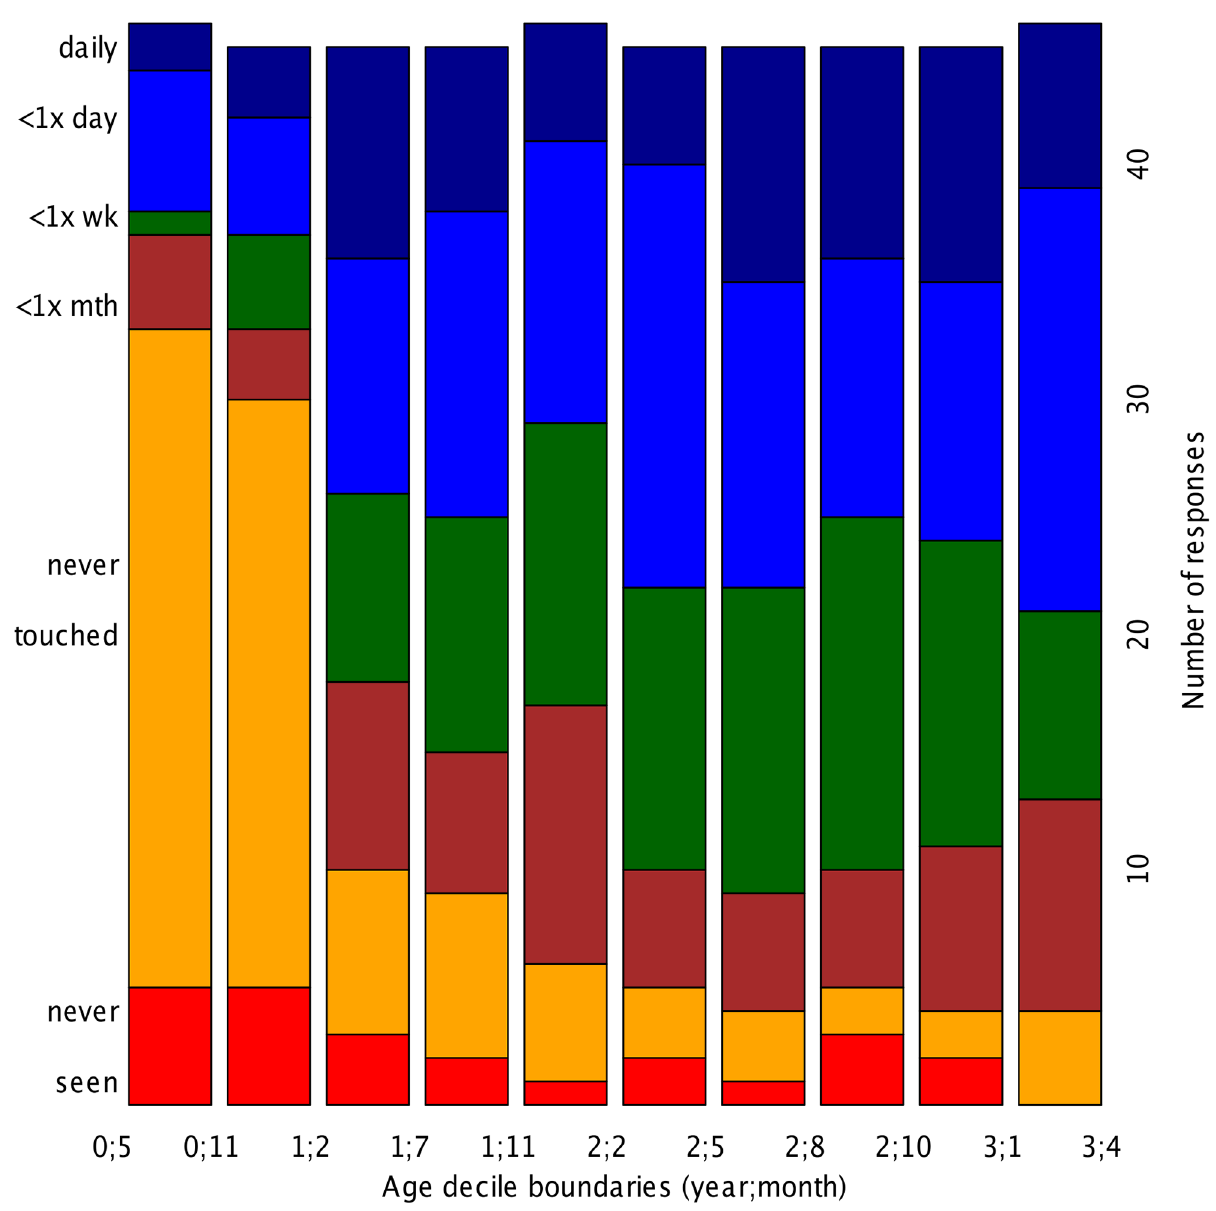
Fig 1. Frequency of use by age. Data is grouped in deciles to even the number of infants in each frequency of use category; “ < 1× ” stands for “ less than once a ” ; “ wk ” stands for “ week ” and “ mth ” for “ month ” .